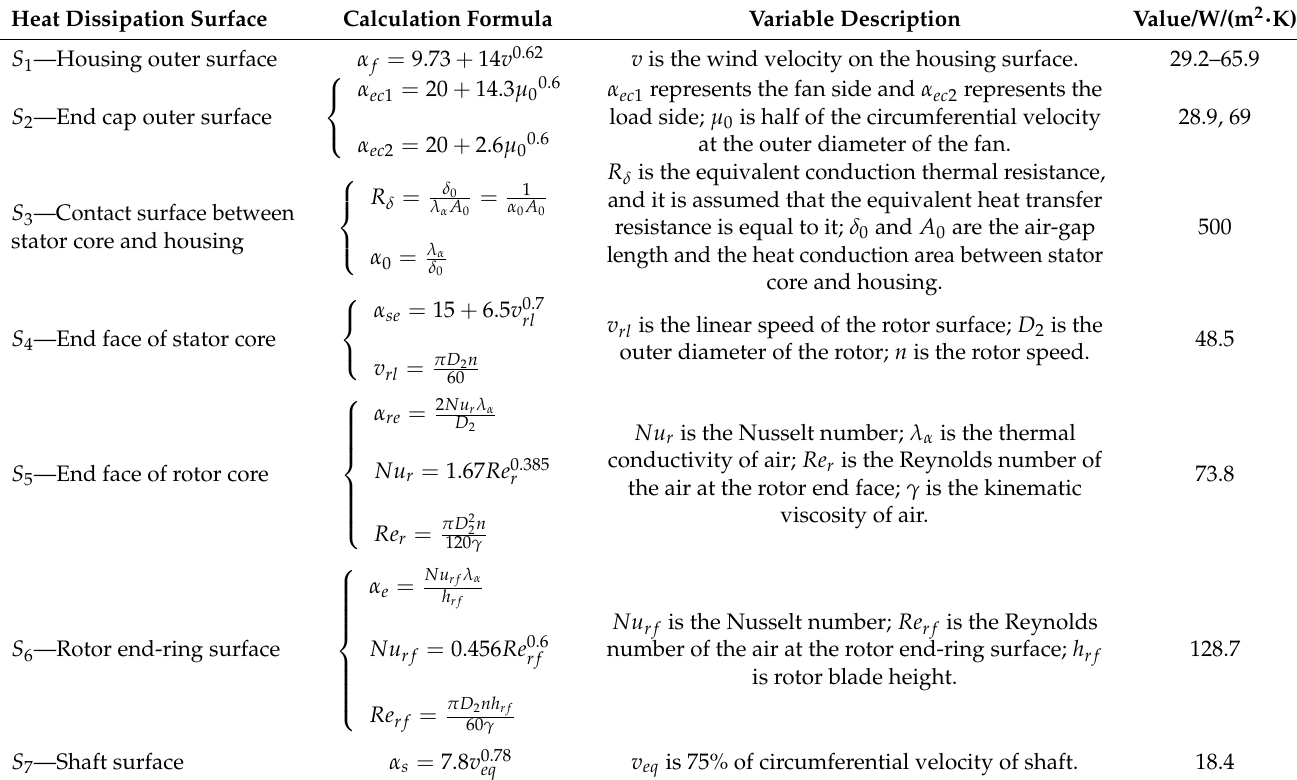
Table 3. Heat dissipation boundary conditions of the simulation